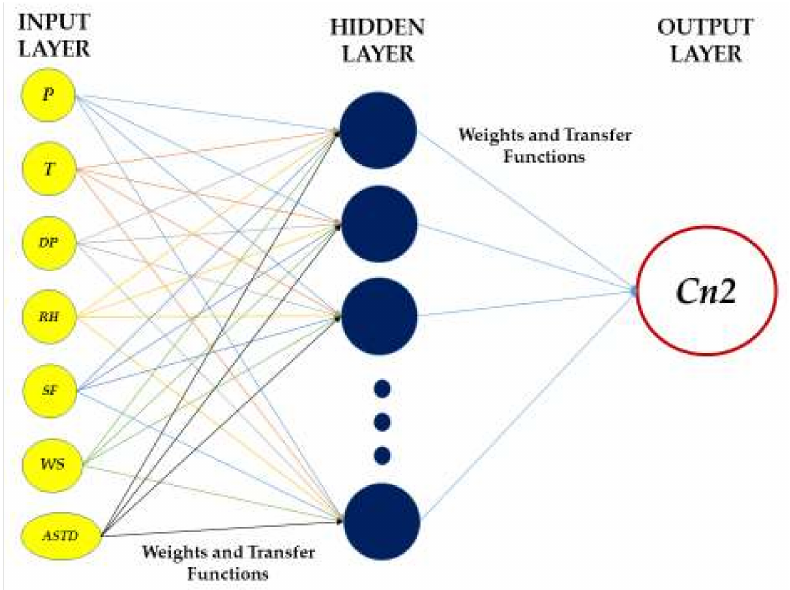
Figure 6. The single-layer perceptron network architecture for the prediction of the refractive index